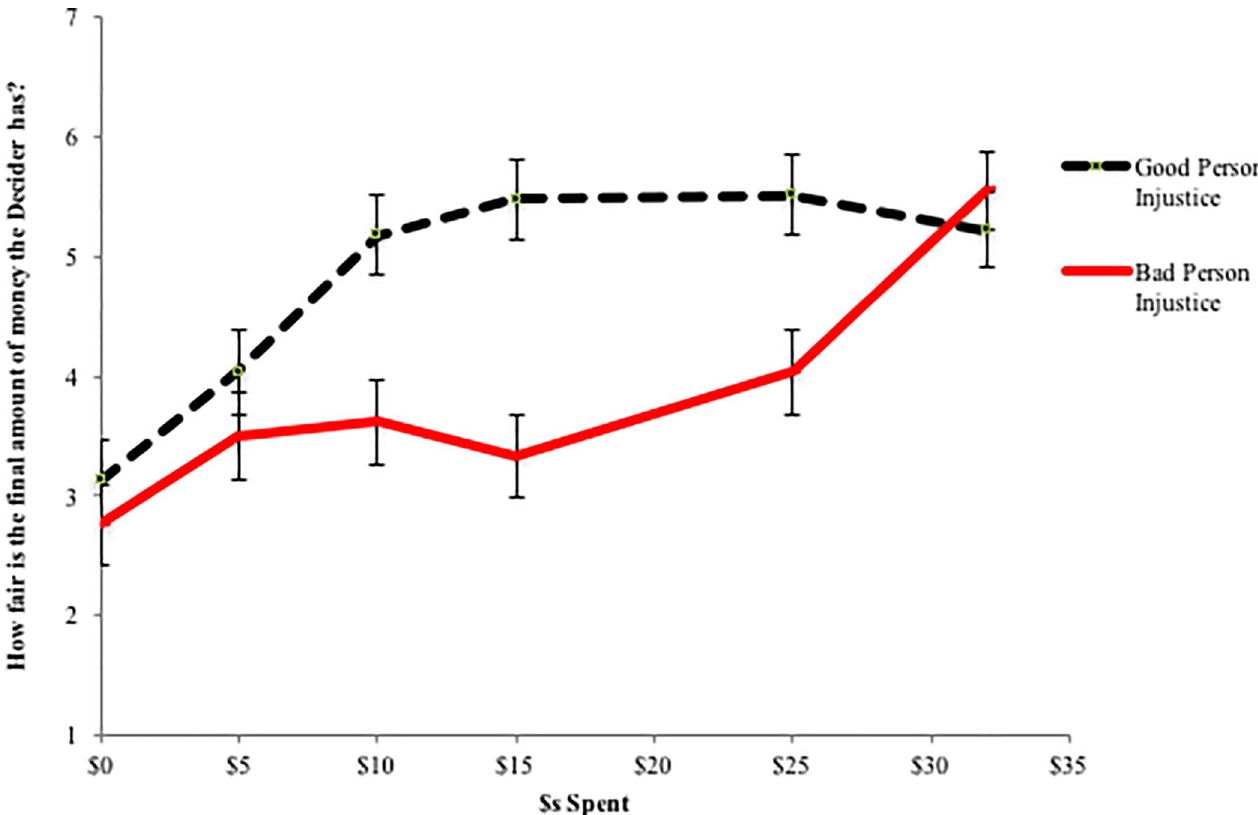
Fig 5. Study 3 perceptions of fairness by condition. Error bars represent standard